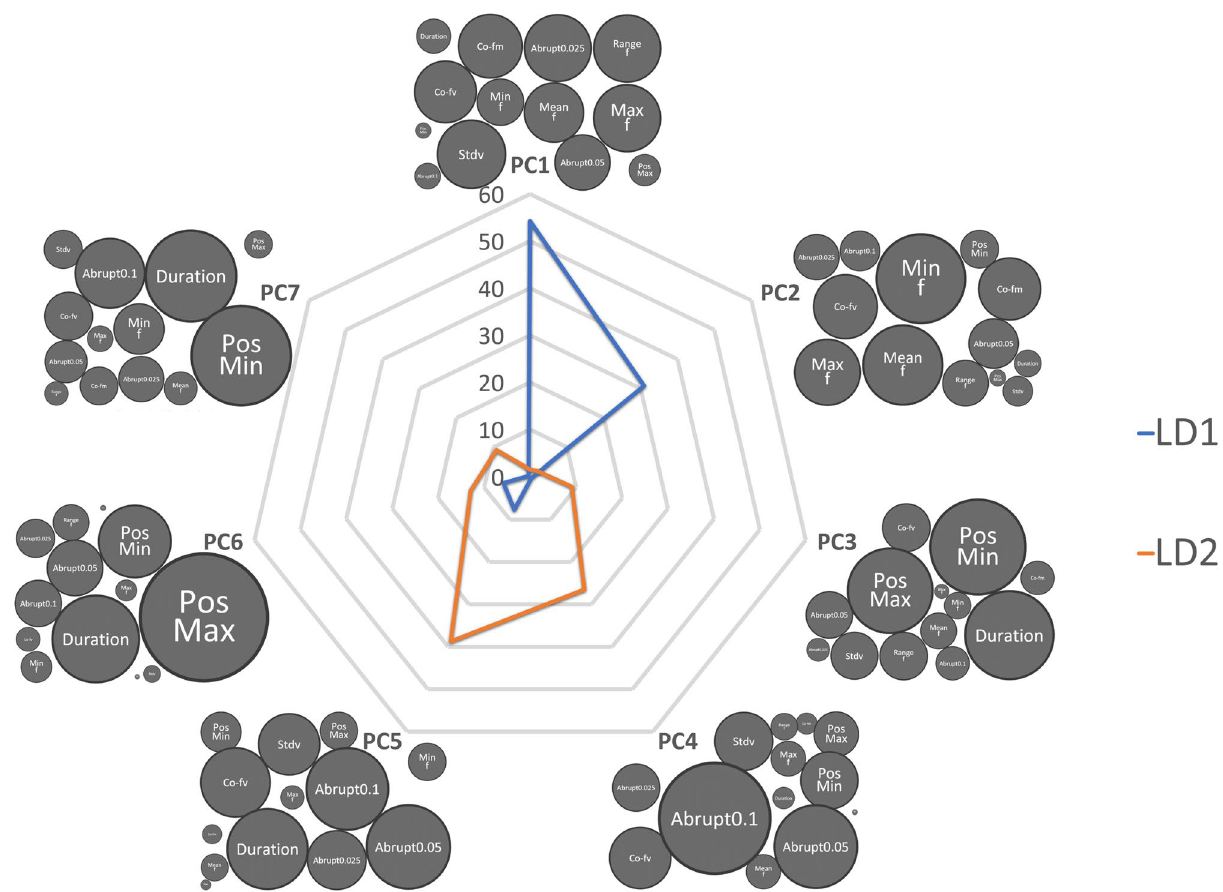
Figure 5. The spider web bubble plot is describing how the Simple Scalar Variables (SSV) are ultimately contributing to two LD functions through PC values. The bubble size of each SSV represents the contribution for building each PC function. The blue line represents LD 1, and Orange represents LD2. Since PC1 and PC2 contribute 85% for LD1, the most important SSVs are Stdv f 0 , Min f 0 , Max f 0 and Mean f 0 . Similarly Duration, Abrupt changes, Co-fv contribute the most in building the LD2 function via PC4 and PC5. LD1 was best defined by the different fundamental frequency factors, while LD2 was best defined through the shape of the frequency contour. Therefore, the critical factors for individuality were encoded in X and Y